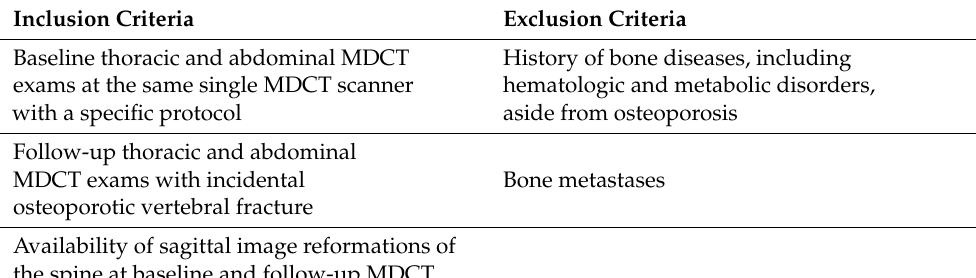
Table 1. Inclusion and exclusion criteria followed in the current study for selecting the MDCT